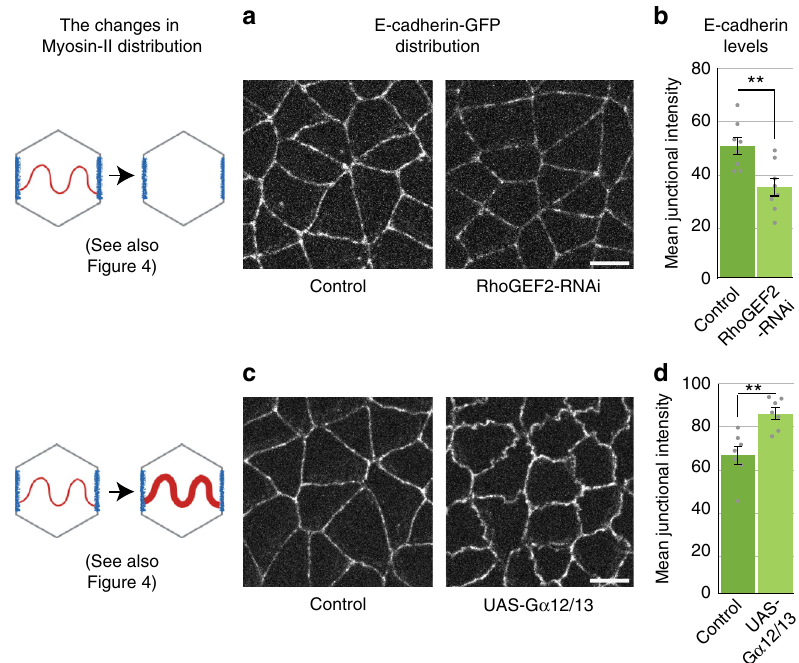
Fig. 5 Medial Myosin-II tunes the levels of junctional E-cadherin. a Representative images showing the distribution of E-cadherin, in the genetic outcross control embryos (left) and RhoGEF2-RNAi embryos (right). b Quanti fi cations showing the reduction in E-cadherin levels, quanti fi ed as mean junctional intensity. Data from n = 8 embryos for both RhoGEF2-RNAi and control. c Representative images showing the distribution of E-cadherin, in the genetic outcross control embryos (left) and G α 12/13 over-expressing embryos (right). d Quanti fi cations showing an increase in E-cadherin levels, quanti fi ed as mean junctional intensity. Data from n = 7 embryos for both G α 12/13 over-expression and control. All scale bars represent 5 μ m. All error bars represent SEM. Statistical signi fi cance estimated using two-tailed Student ’ s t -test. Images/quanti fi cations in all panels come from embryo co-expressing MyoII- mCherry and E-cadherin-GFP, though the proportion of tagged vs untagged protein pool varies across different experiments (detailed in Methods: Fly lines and genetics). Corresponding Myosin-II related images/quanti fi cations are presented in Figure 4. In all cases, Junctions marked based on E-cadherin localization. ns, p > 0.05; *, p < 0.05; **, p < 0.01; ***, p <